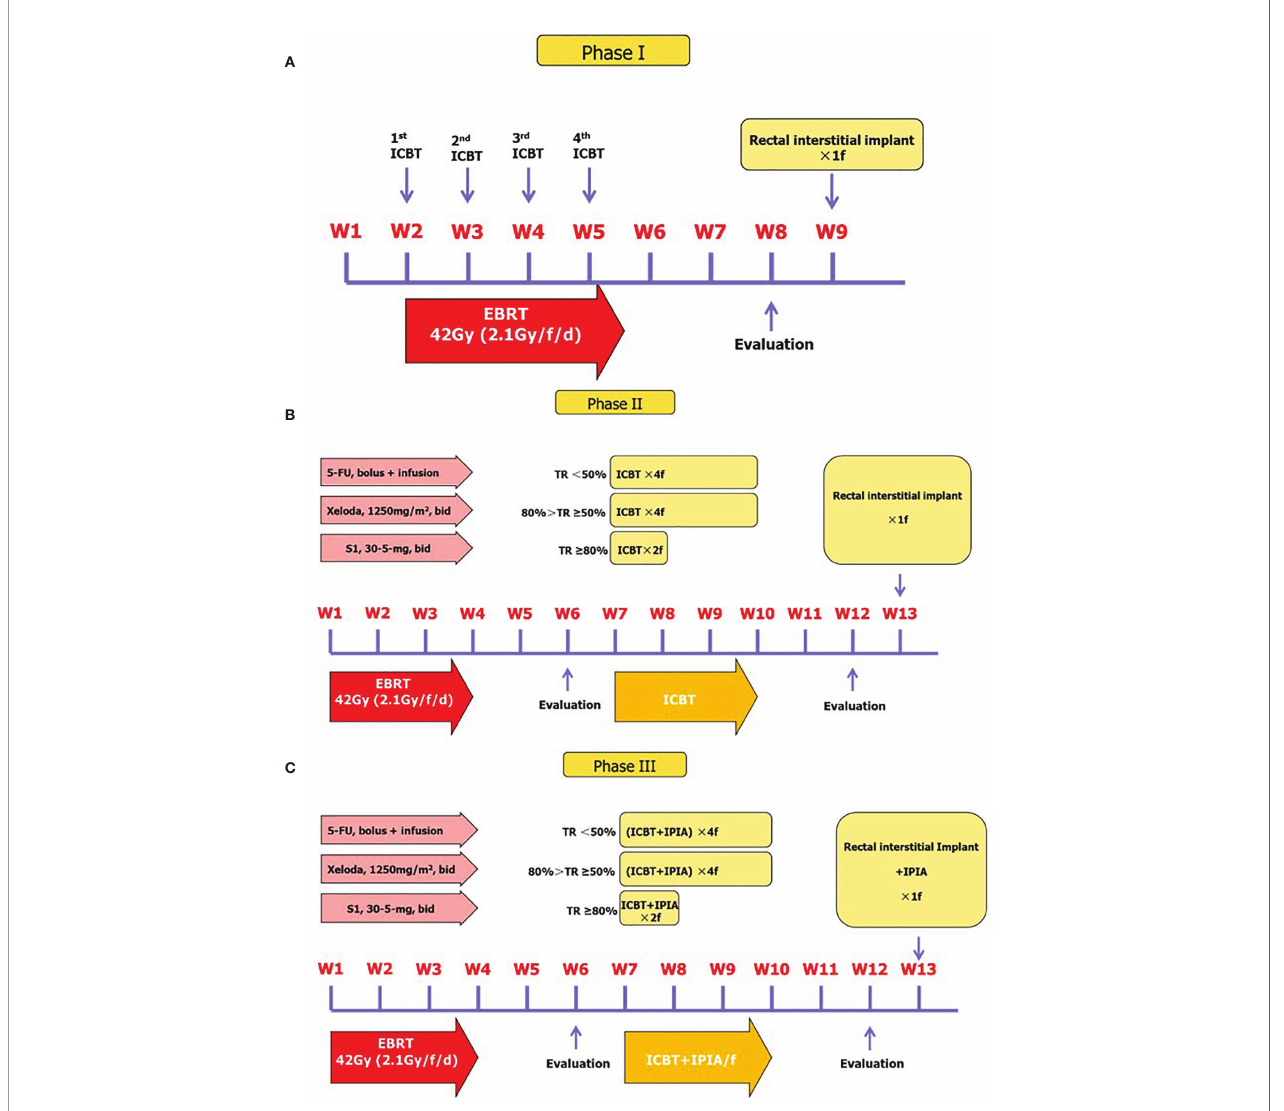
FIGURE 2 | Treatment protocols for each phase of the current study. (A) Phase I treatment protocol. (B) Phase II treatment protocol and algorithm for patients with different response to initial therapy. (C) Phase III treatment